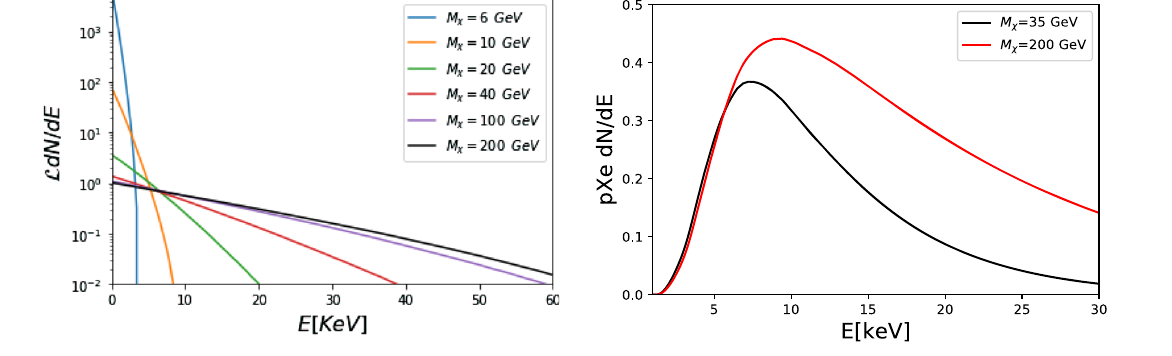
Fig. 1 Left: predictions for the recoil energy distribution of Xenon nuclei for an exposure L = 279 × 900 kg · days and σ 90 = 248 . 6 , 5 . 39 , 0 . 566 , 0 . 448 , 0 . 912 , 1 . 71 × 10 − 46 cm 2 for M χ =